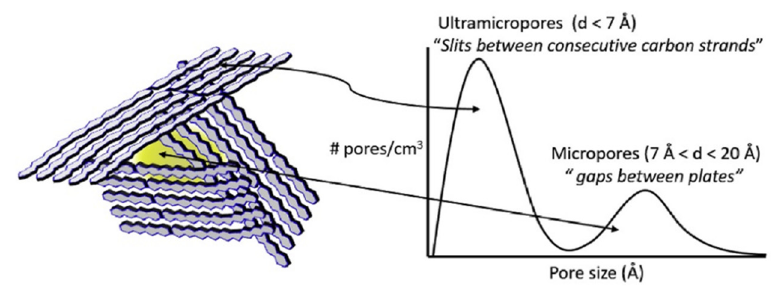
Figure 3. Turbostratic CMSM structure with idealized pore size distribution (adapted with permission from [26]).